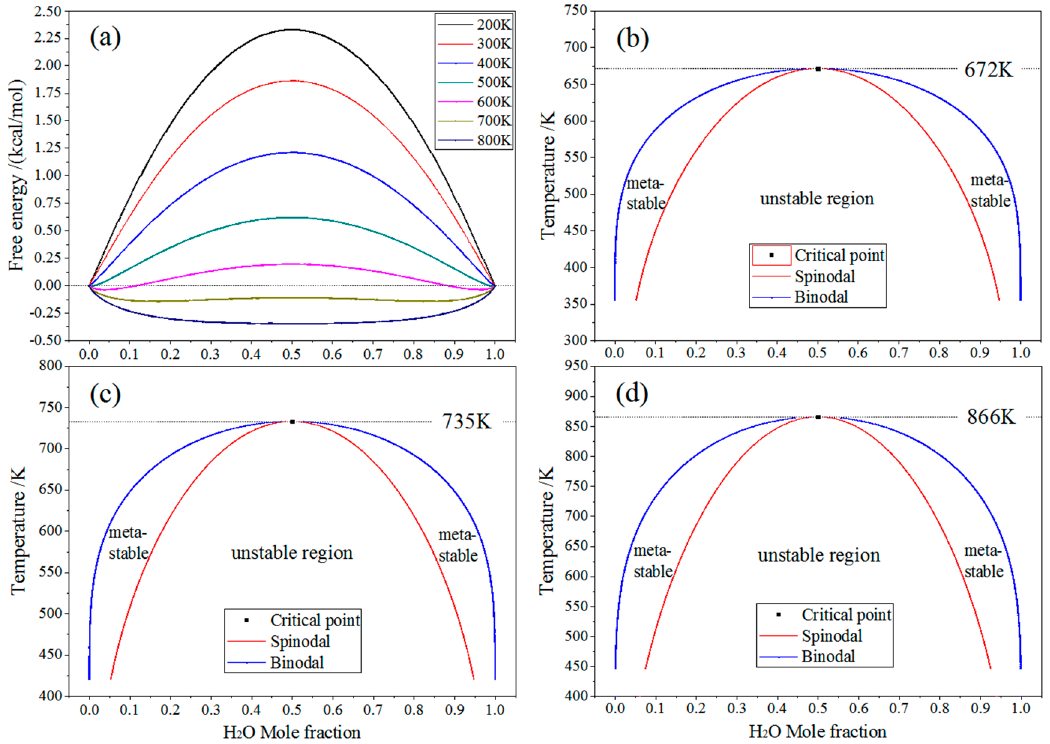
Figure 6. ( a ) The free energy of mixing for TAIC/H 2 O mixture varying with mole fraction for 200–800 K temperatures; mixture phase diagrams of ( b ) TAIC/H 2 O, ( c ) TMPTMA/H 2 O, and ( d ) HAV2/H 2 O binary systems.